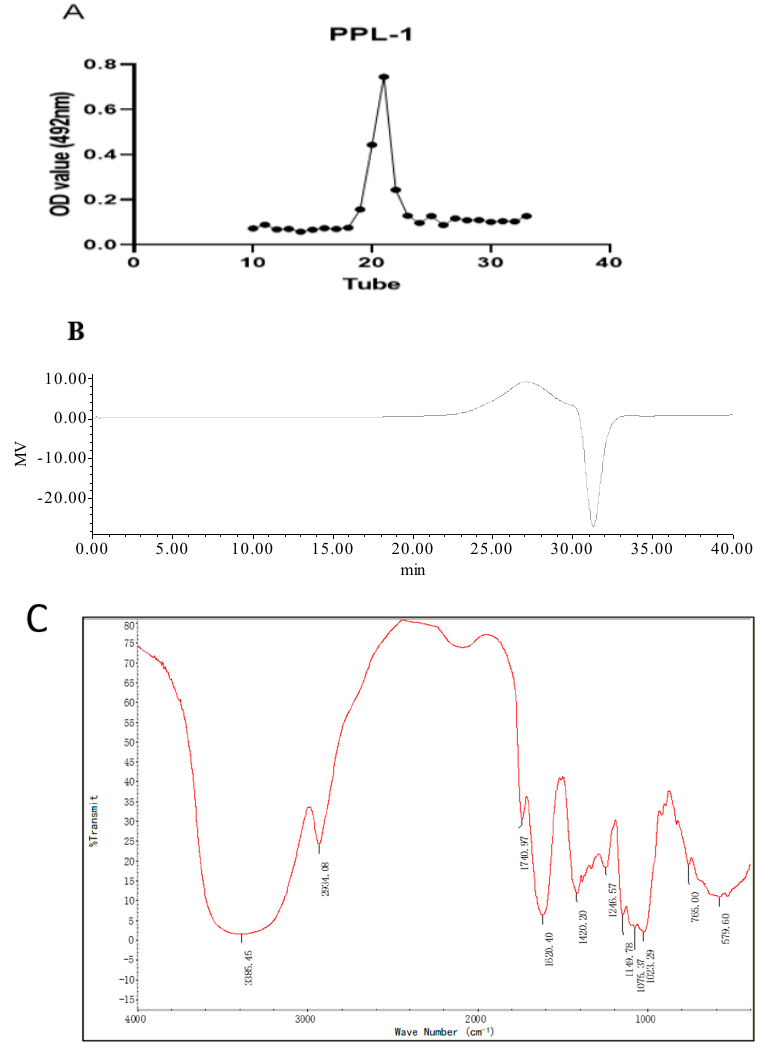
Figure 1. Elution curve ( A ) of PPL-1 on a SephadexG-100 column. UV spectrum ( B ) of PPL-1andFTIR spectrum ( C ).